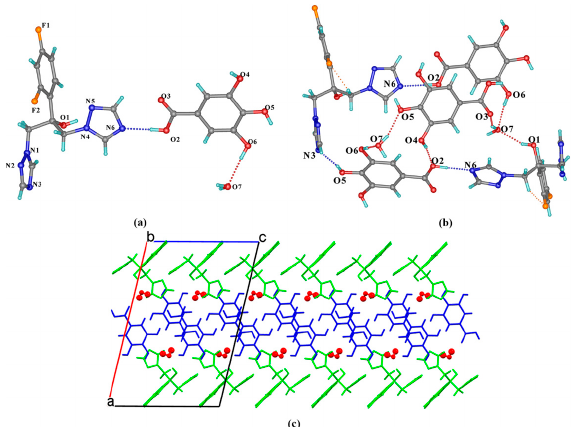
Figure 6. ( a ) Hydrogen-bonding interactions in an asymmetric unit; ( b ) the hydrogen-bonded motifs composed of FLZ, 345THB, and water molecules; ( c ) hydrogen-bonded sandwich-like 3D structure with water molecules in space-filled mode. a,b,c in subfigure ( c ) represents the three axes of the cell. 3.3. Structure Overlay Literature reported by Caira, et al. [14] has seen the torsional flexibility in FLZ poly- morphs. The two triazole rings of FLZ may be twisted after the introduction of CCFs or water/solvent molecules. To investigate whether the configuration of the FLZ molecule has changed in the newly obtained cocrystal forms, the molecular overlay was performed, and it can be seen that the configuration of FLZ varied greatly among the five cocrystal hydrate forms concerning FLZ form II (Table 2, Figure 7). The formation of the polymor- phic form of FLZ − 34DHB − H 2 O (1:1:1) enables the most obvious change of FLZ configura- tion, wherein one of the triazole rings flips, and the corresponding torsion angle τ 1 rotates 116.87° in comparison with FLZ form II. Hydrogen-bonding interactions with CCFs can alter the conformation of the molecule due to the requirements of different molecular packing patterns, on the other hand, the conformation flexibility of the API has prompted the molecule to have different conformers such that the different CCFs could recognize, thus extending the scope of cocrystal screening and amplifying the range of solid forms.